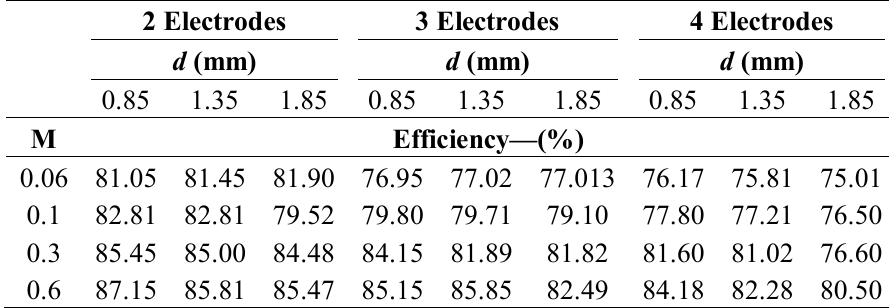
Table 3. Desalination system efficiency for several geometrical configurations with I changing during the transference process.